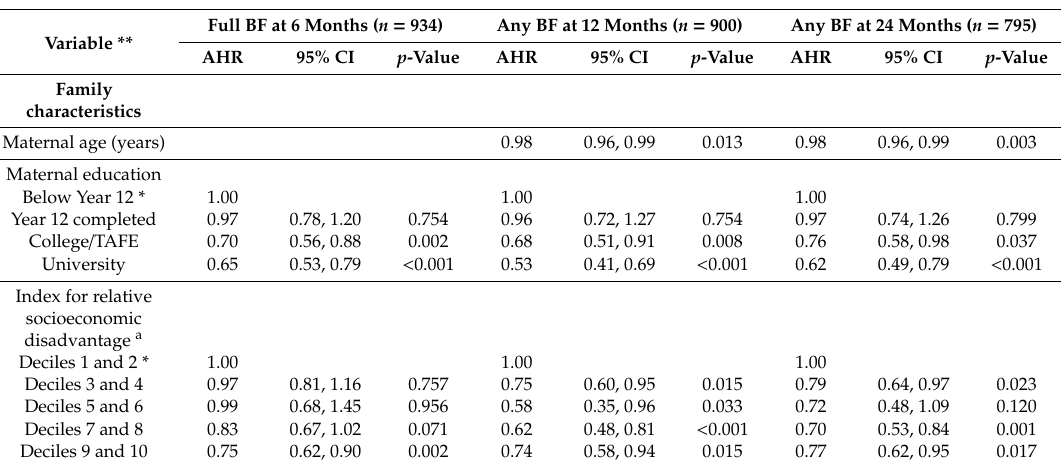
Table 2. Factors independently associated with the risk of stopping full breastfeeding at six months and any breastfeeding at 12 and 24